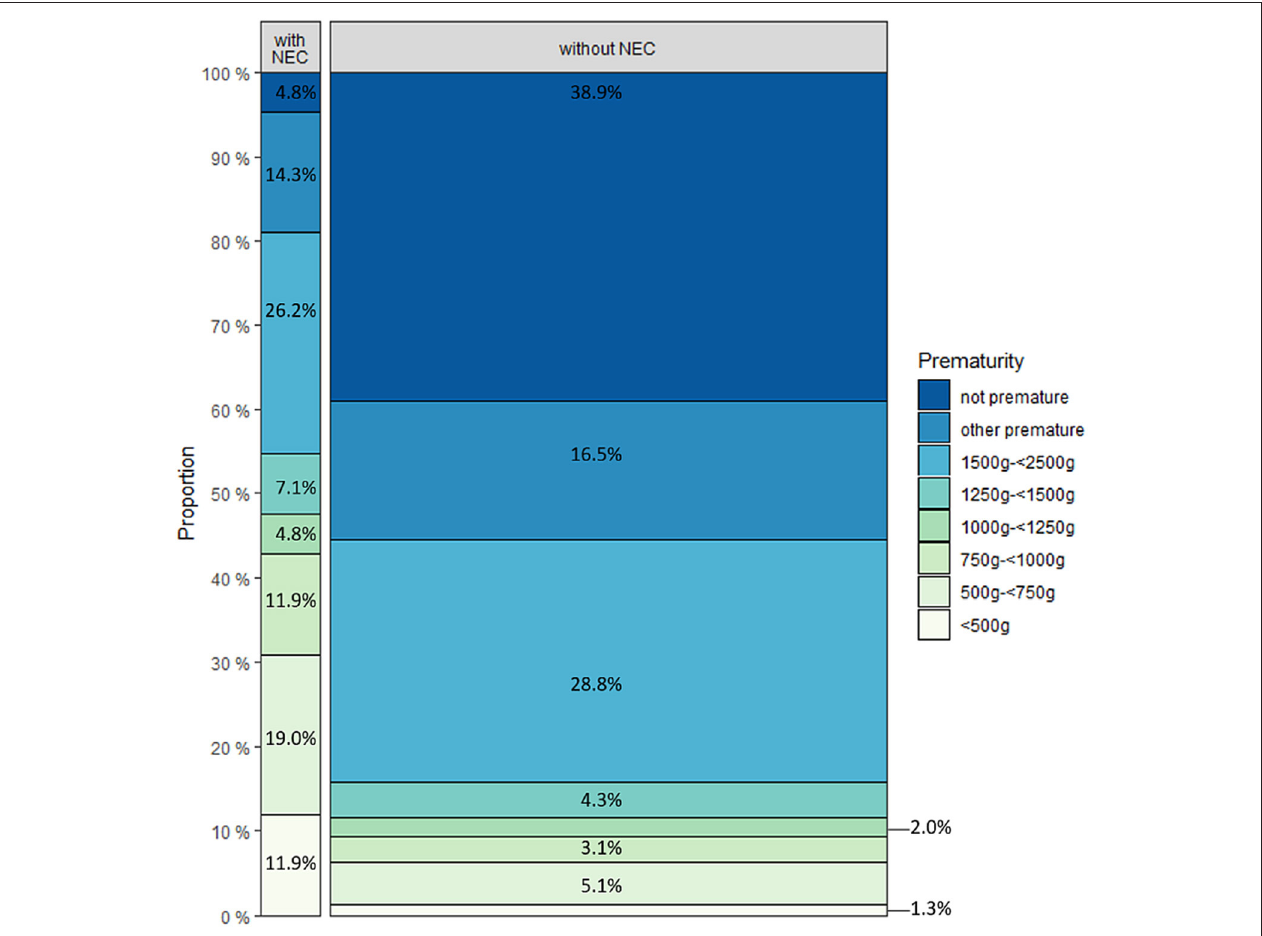
FIGURE 1 | Distribution of patients with ( n = 42) and without ( n = 393) necrotizing enterocolitis regarding